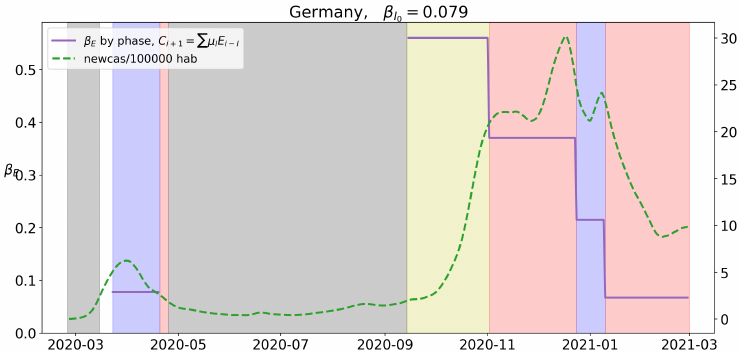
Figure 14. Value of β E for the different levels of lockdown. Blue background will correspond to Stage 1, red to Stage 2, yellow to Stage 3 and white to Stage 4. A green dotted line corresponds to the value of new cases per 100,000 hab.